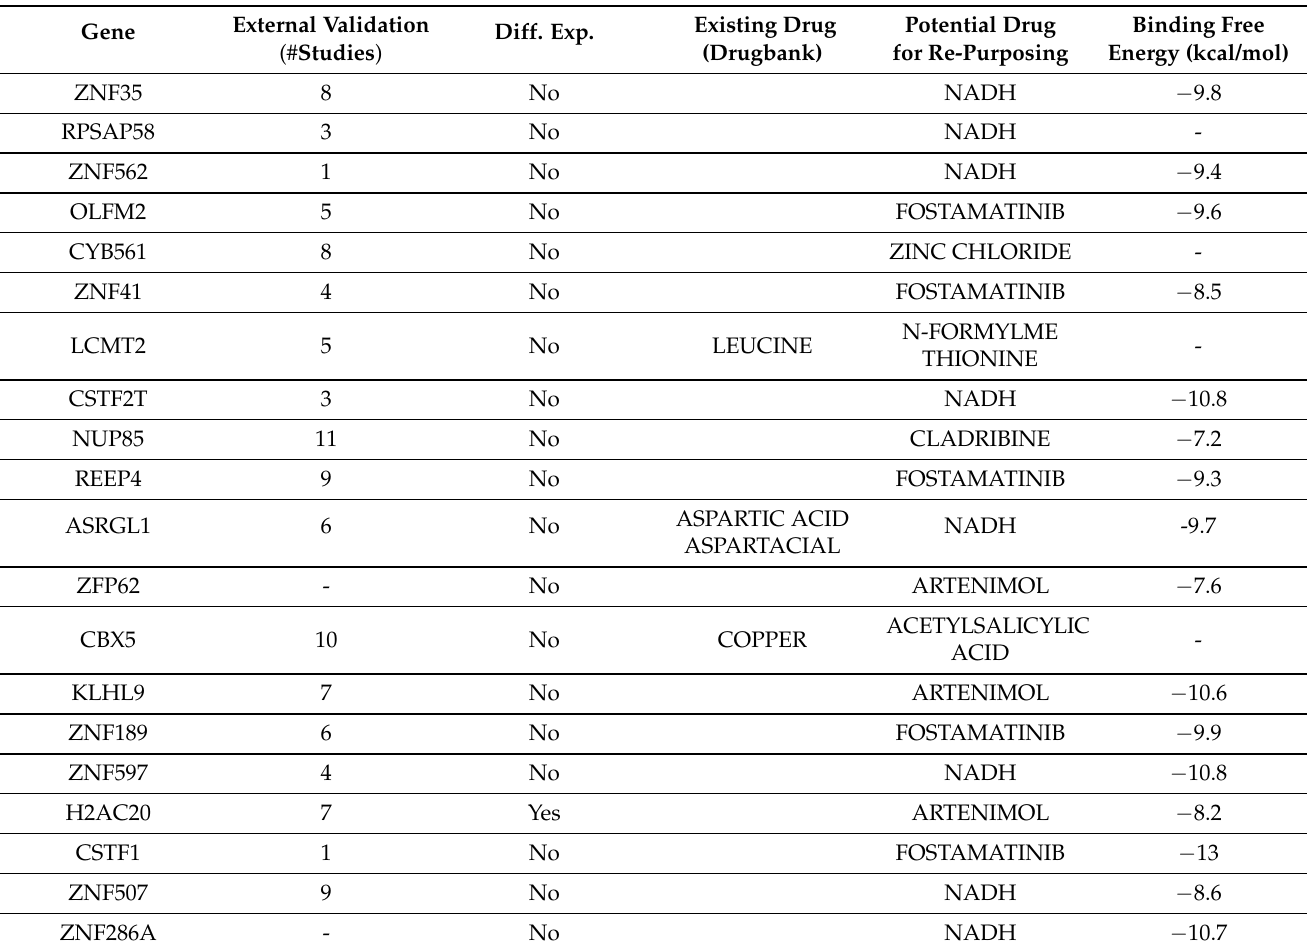
Table 4. Twenty most rewired genes in patient iCells. For each of the 20 most rewired genes in patient iCells of infected versus control (column 1), we report the number of other studies that have reported it as a COVID-19-related gene (column 2) and if it is a differentially expressed gene (column 3). In addition, we report if it is already targeted by an FDA-approved drug (column 4) and the potential drug for re-purposing based on our framework (column 5). Finally, for each predicted DTI, we report its binding free energy (column 6) computed using AutoDock Vina v1.2 [45]. Note that we could not find a experimentally validated or predicted protein structure for RPSAP58 , so we could not perform the docking for it. Additionally, we excluded from the drugs the small chemical compounds (zinc chloride, n-formylmethionine and acetylsalicylic